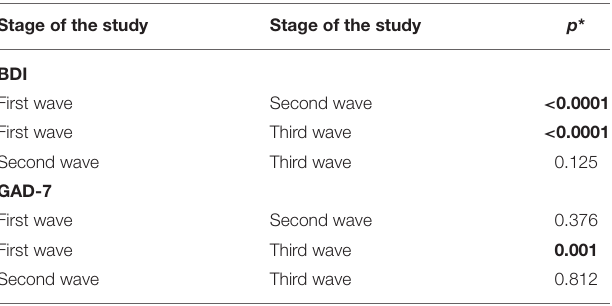
TABLE 4 | Pairwise comparison of BDI interpretations between individual waves of the COVID-19 pandemic. Interpretation